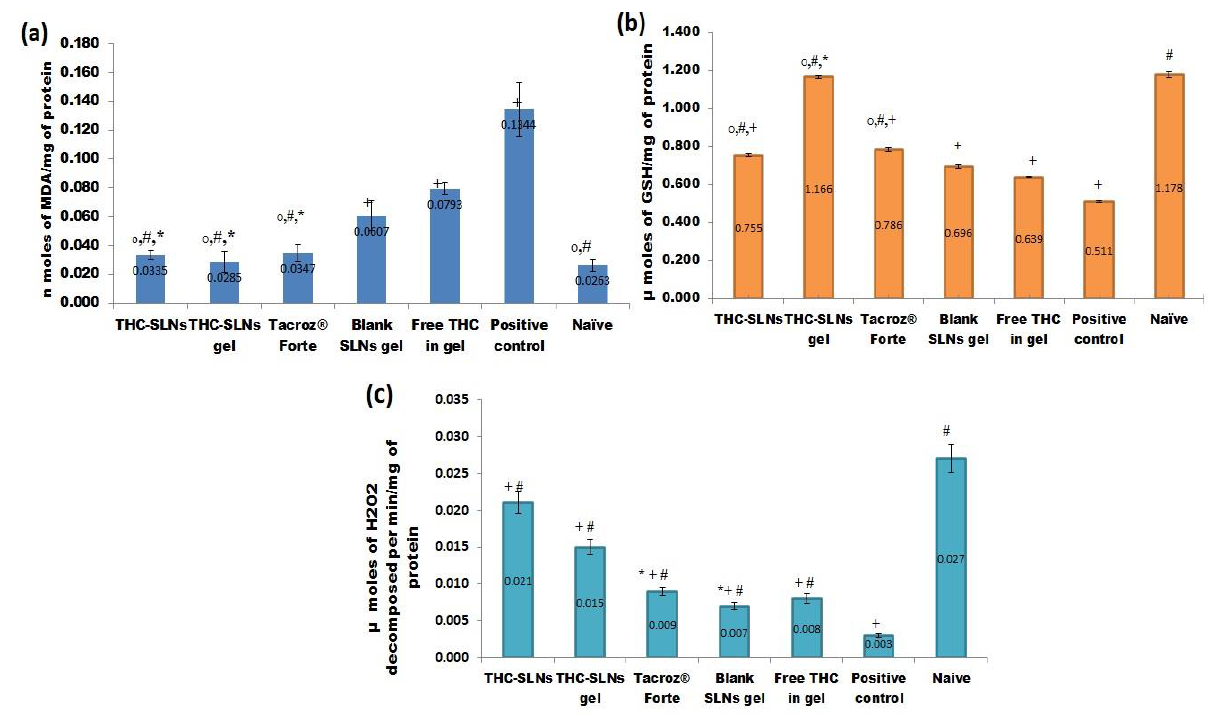
Figure 6. ( a ) Effects of THC-SLN gel, THC-SLN dispersion, Tacroz ® Forte, blank SLN gel, free THC gel, positive control and plain gel on lipid peroxidation in the mouse skin of AD models. Values are expressed as mean ± SD (one-way ANOVA followed by Tukey’s test): * denotes insignificant difference at p ≤ 0.05 from naïve group; + denotes significant difference as c.f. naïve group; # c.f. positive control; o c.f. free THC gel group. ( b ) Effects of THC-SLN gel, THC-SLN dispersion, Tacroz ® Forte, blank SLN gel, free THC gel, positive control and plain gel on the reduced glutathione levels